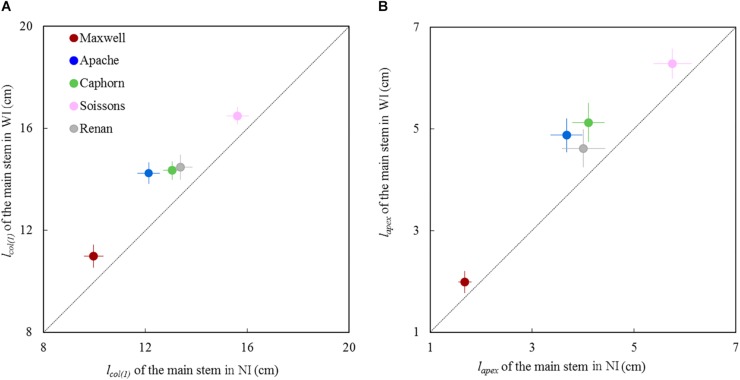
Length of the main stem in WI treatments vs. NI treatments at the start of stem extension (870°Cd). (A) shows lcol(1), which represents the length from the base of the plant up to the highest collar and figure (B) shows lapex, the length from the base of plant to the summit of the apex. Each symbol represents the mean of values measured on 30 stems. Each color is associated with a cultivar, as indicated in the legend. Error bars represent 95% confidence intervals of mean estimates. The dotted line represents the line 1:1.